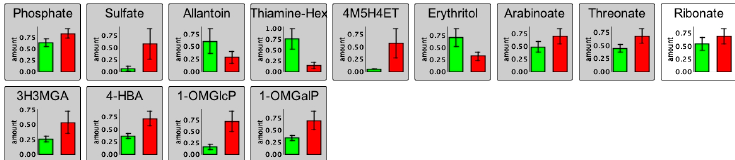
Figure 6. Differentially expressed primary metabolites occurring in root extracts of A. thaliana . Control and treatments are color-coded; control: A. thaliana (green) and treatment: A. thaliana + P. indica (red). Compounds with p < 0.01 are specifically marked by grey color or left blank for 0.01 ≤ p ≤ 0.05. GPG: glycerophosphoglycerol; 4M5HET: 4-methyl-5-hydroxyethylthiazole; 3H3MGA: